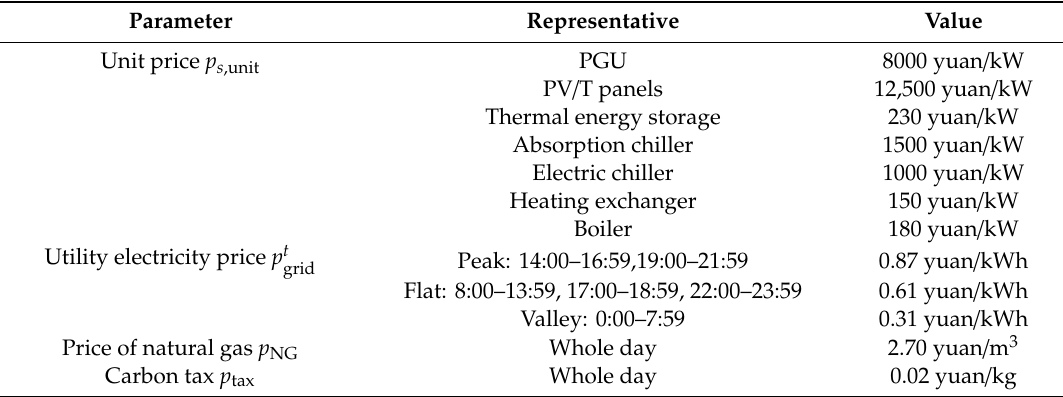
Table 3. Economic parameters of the CCHP system.